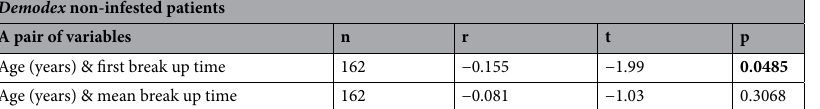
Table 9. Results of the significance the Pearson linear correlation between the age of the non-infested patients and the first and mean break-up times in both eyes. Pearson’s linear correlation coefficient (r), t-value (t), p-value (p). Significant value in